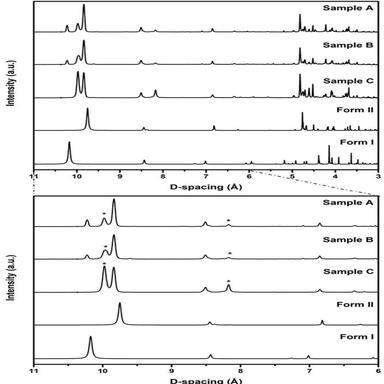
Identification of crystalline phases present in 3 samples of OLZ and calculated X-ray patterns of OLZ polymorph I (UNOGIN01) and polymorph II (UNOGIN02). (a) Experimental synchrotron X-ray diffraction patterns and (b) a magnification showing the phases identified in each sample and the indication of reflections (\) of polymorph III.